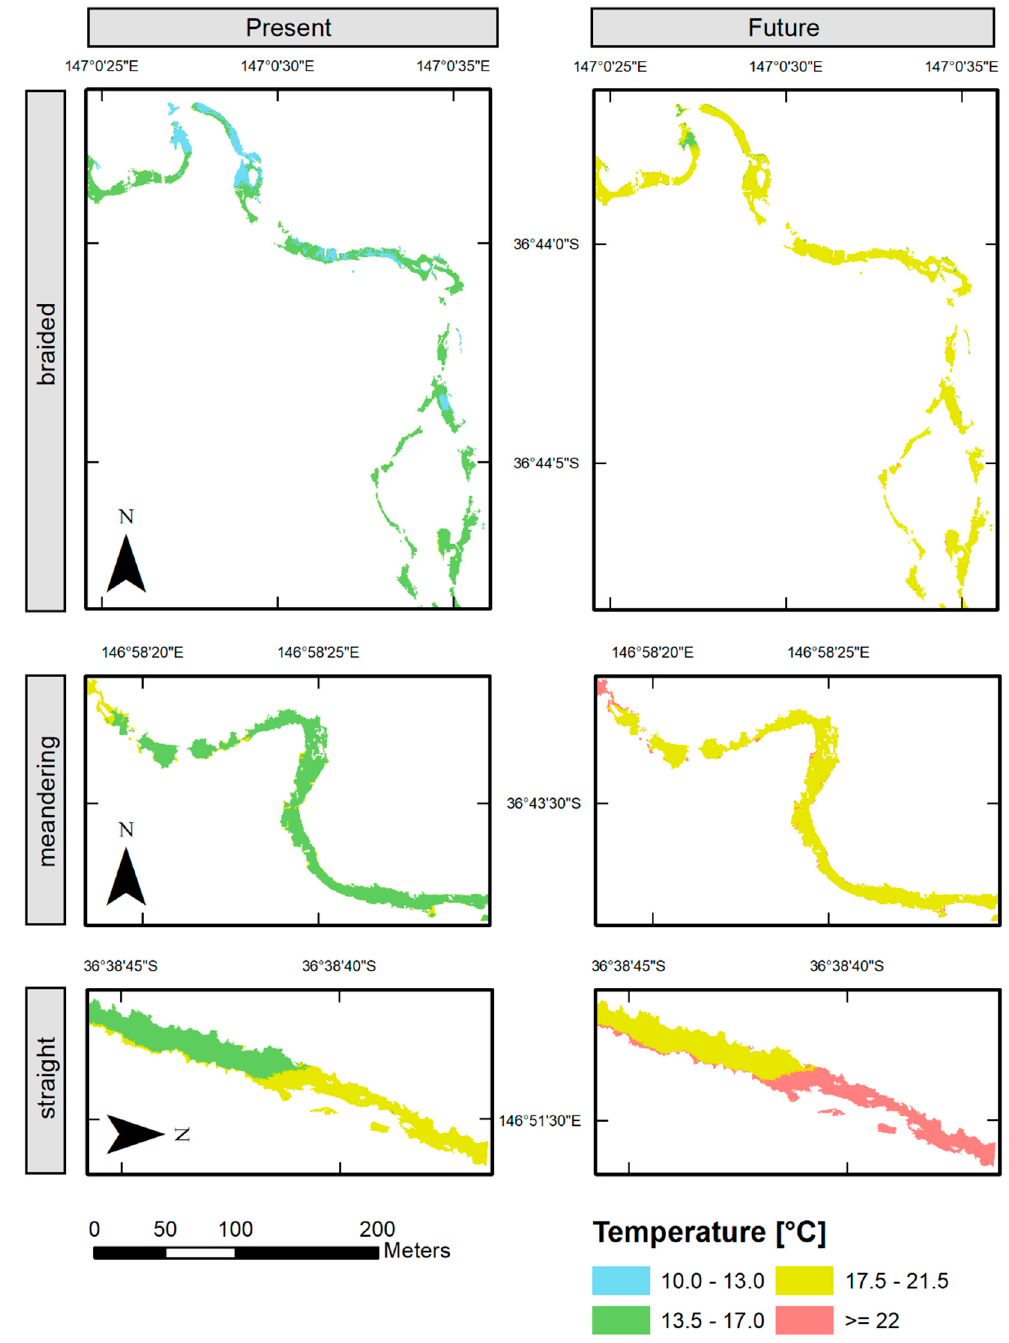
Figure 7. Changes in thermal habitat availability between present conditions ( left ) and future predicted water temperature warming, as represented by a 4 ◦ C increase ( right ). The figure depicts a small section of each representative braided (S1), meandering (S4), and straight (S5) reaches or survey sections.